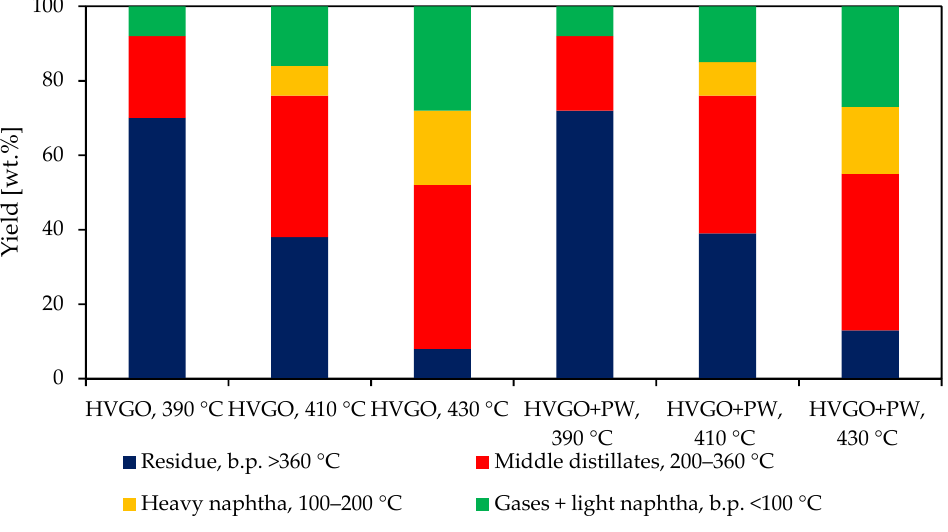
Figure 2. Fraction composition of the primary products obtained by hydrocracking of HVGO and HVGO + PW at various temperatures.